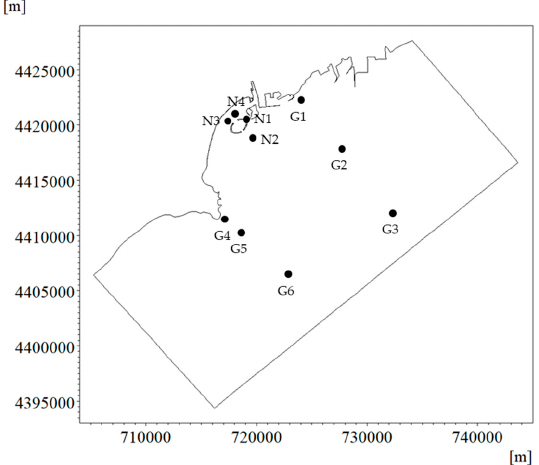
Figure 6. Field observation sites of COD (G1~6) and NO 3 − (N1~4).